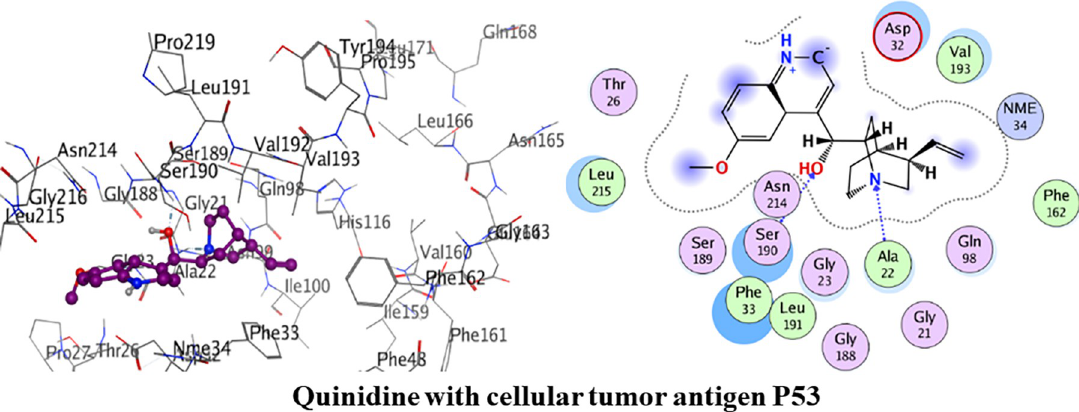
Fig 12. . 3D and 2D interactions of quinidine with active site of cellular tumor antigen